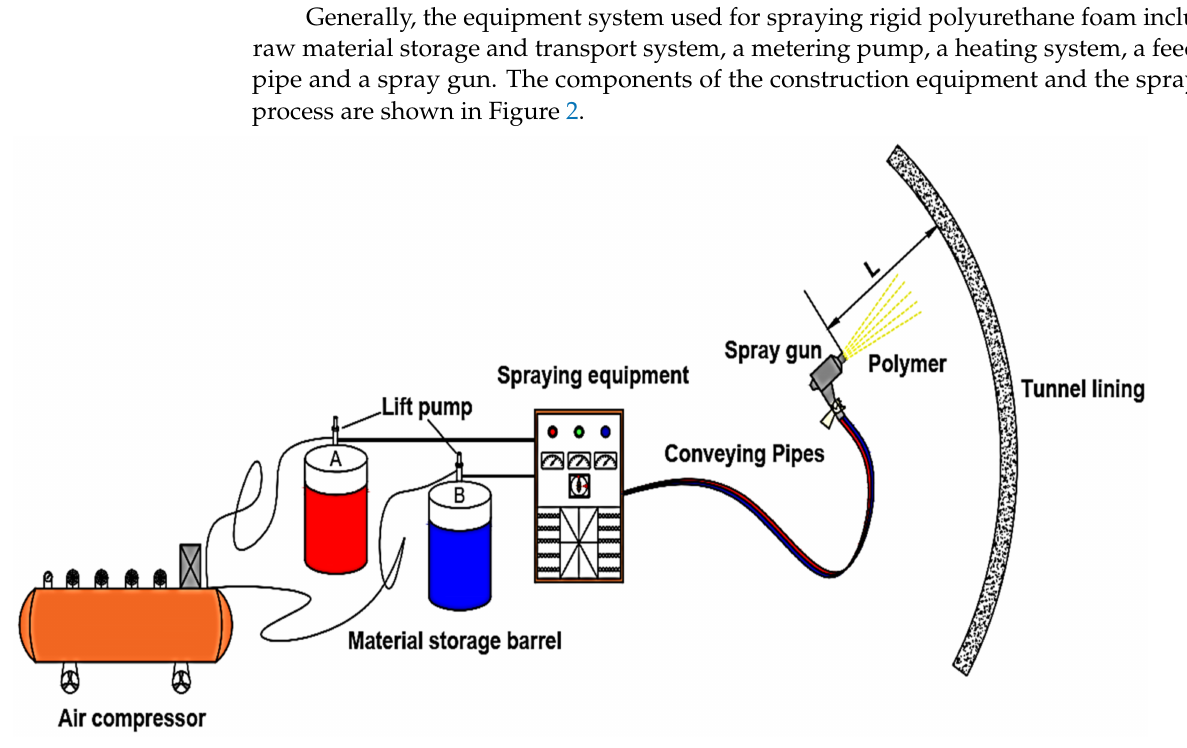
Figure 2. Schematic diagram of polymer spraying construction system and spraying